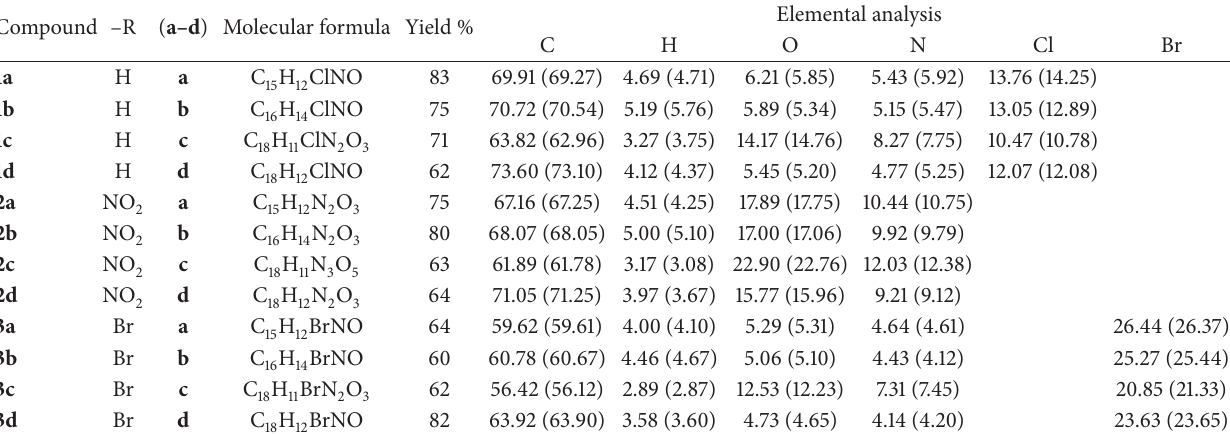
Table 1: Physical properties of synthesized